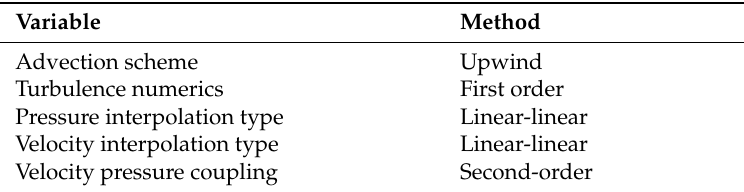
Table 1. Discretization scheme and Interpolation